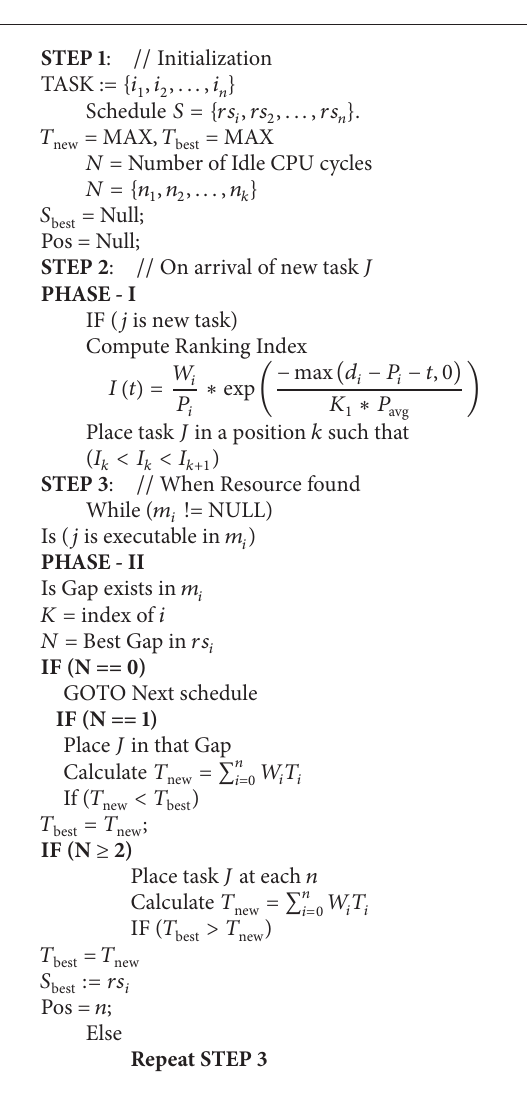
Algorithm 1: BG ATC algorithm (BG